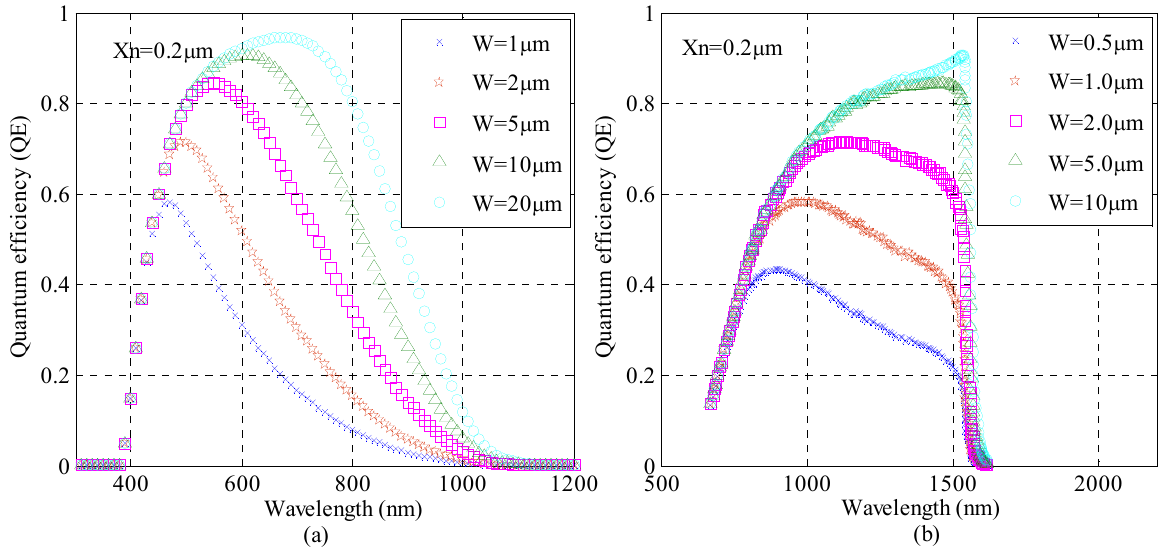
Figure 6. Quantum efficiency with different wavelength: ( a ) Si; ( b ) Ge. (Xn: distance from surface to depletion region; W: depletion region width).